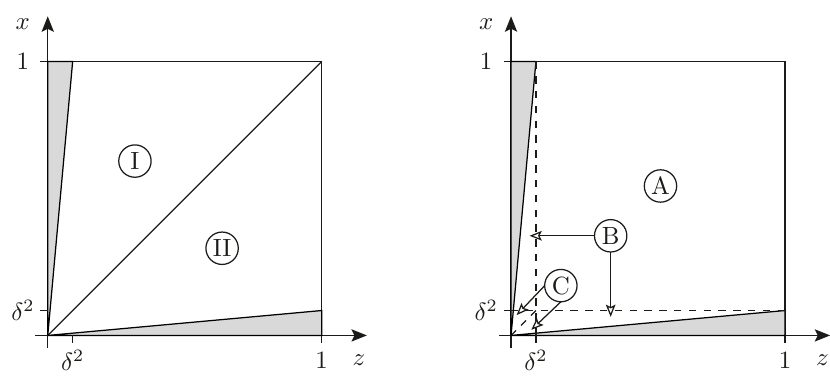
Figure 7 . Illustration of the integrations in the r < 1 (I) and r > 1 (II) contribution to I reg of eq. (5.9) (white triangles, l.h.s.). They can be viewed as the integral over a square (A) plus two wedges (B) minus two small triangles (C) (delimited by dashed lines, r.h.s.).